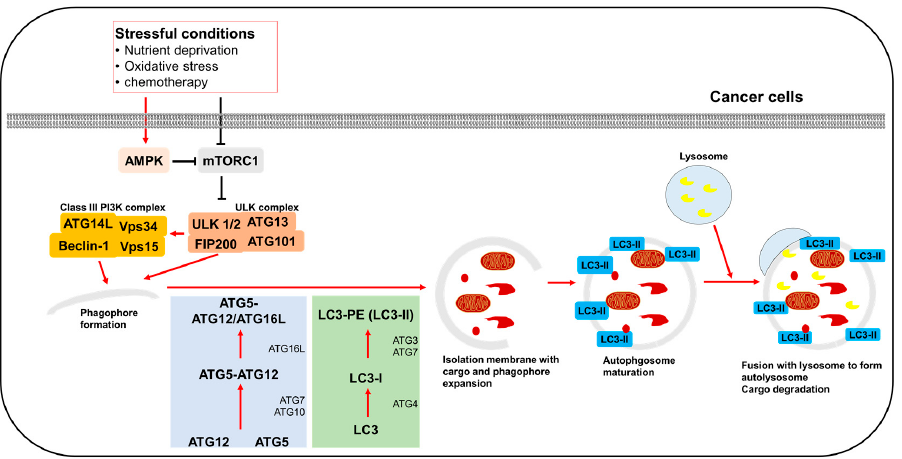
Figure 1. A schema illustrating the regulation of the autophagic pathway under diverse stressful conditions in cancer cells. conditions in cancer